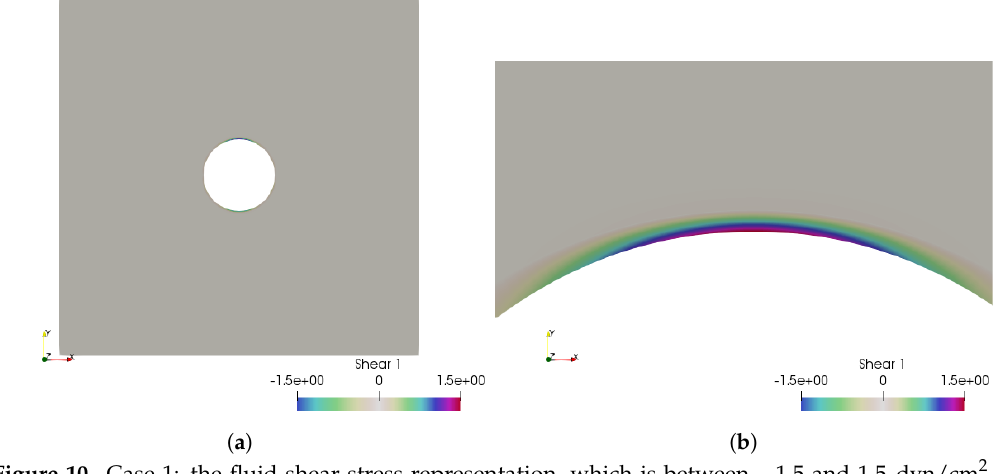
Figure 10. Case 1: the fluid shear stress representation, which is between − 1.5 and 1.5 dyn/cm 2 , for h 1 -refinement. ( a ) The fluid shear stress overview; ( b ) zoom over the higher shear stress